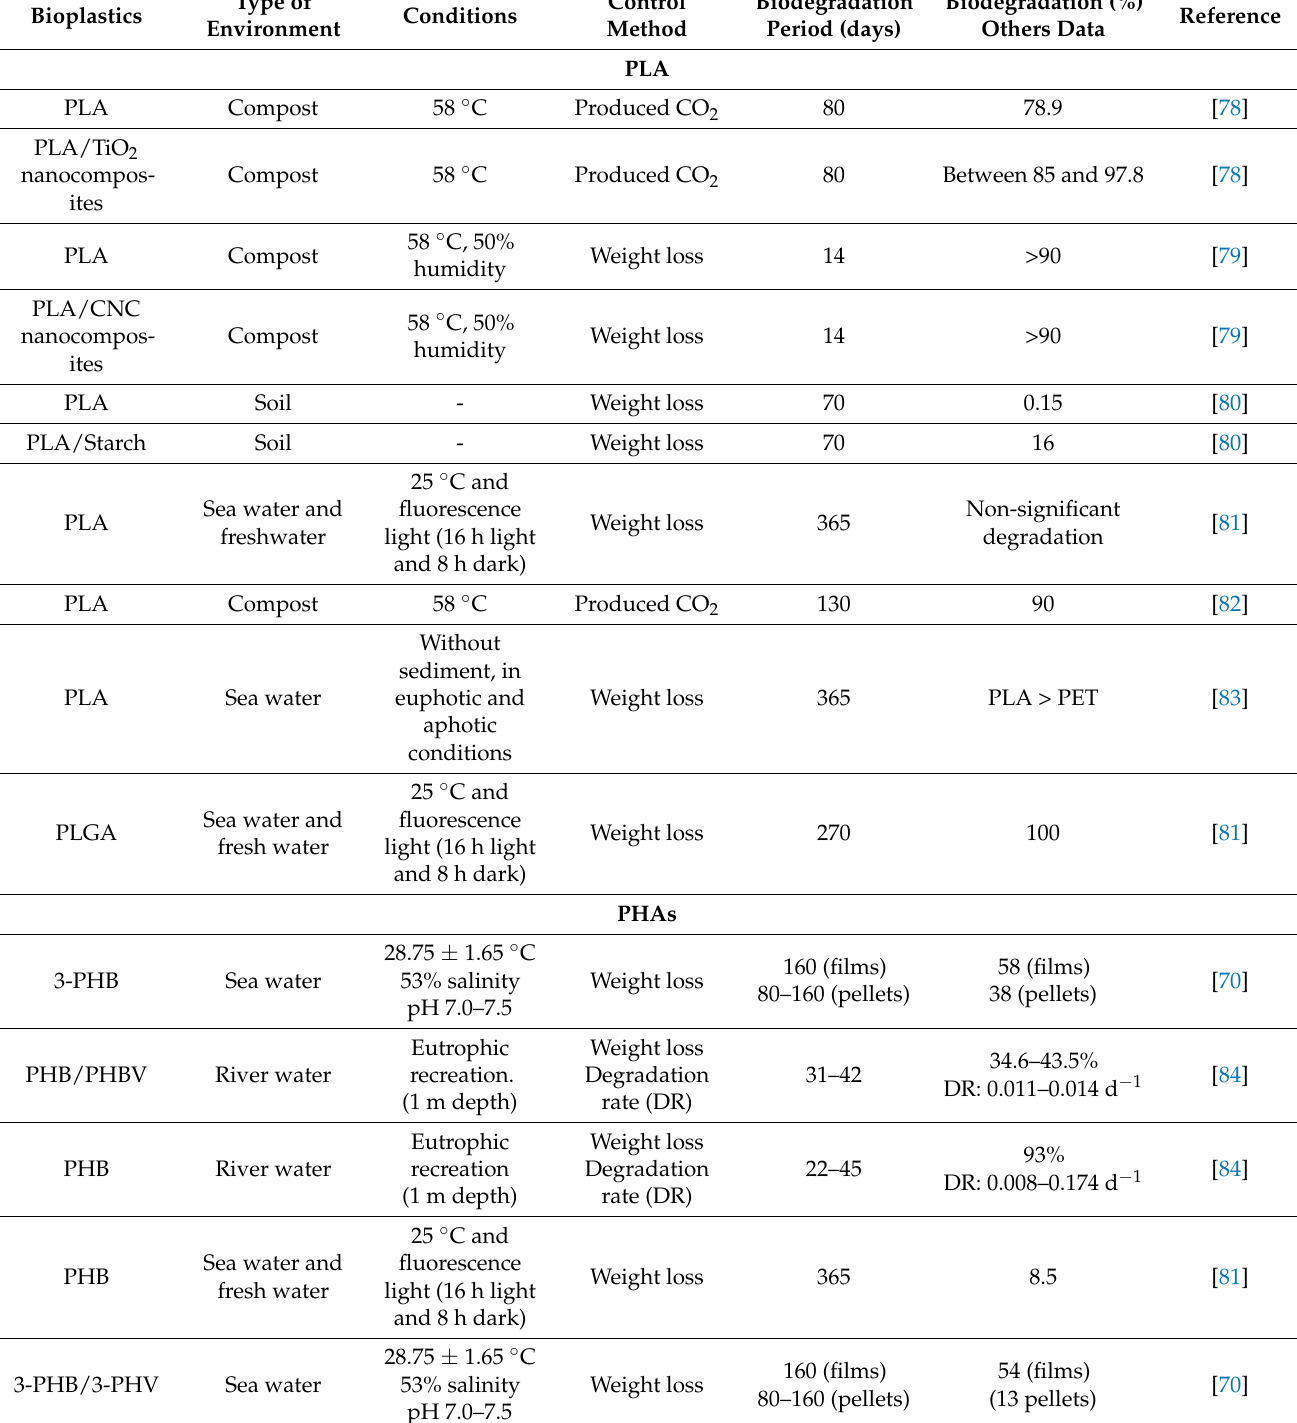
Table 4. Biodegradation studies of some bioplastics in compost, soil or aquatic environments.